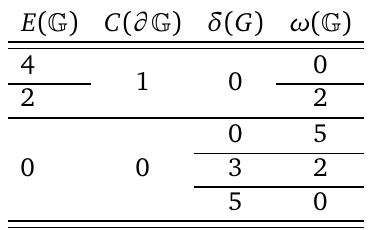
Table 1: Characteristics of superficially divergent